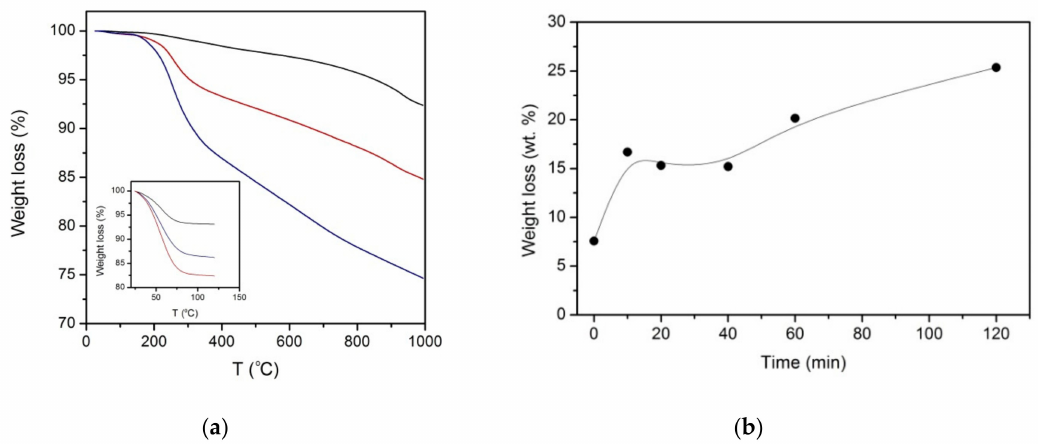
Figure 8. ( a ) TGA curves of unmodified ACC (black line) and hybrid PAni-ACC composites synthesized after 40 min (red line) and 120 min (blue line) of galvanostatic electropolymerization; the inset shows the thermal pattern during the first thermogravimetric run up to 120 ◦ C; the main panel shows the thermal behavior of the resulting dried samples; ( b ) Evolution of the total weight loss at 1000 ◦ C for heat-dried PAni-ACC composites obtained at di ff erent electropolymerization